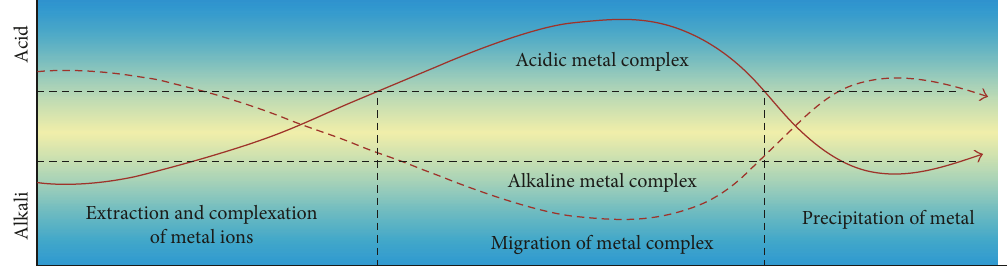
Figure 2: Schematic diagram on the formation, migration, and precipitation of metal